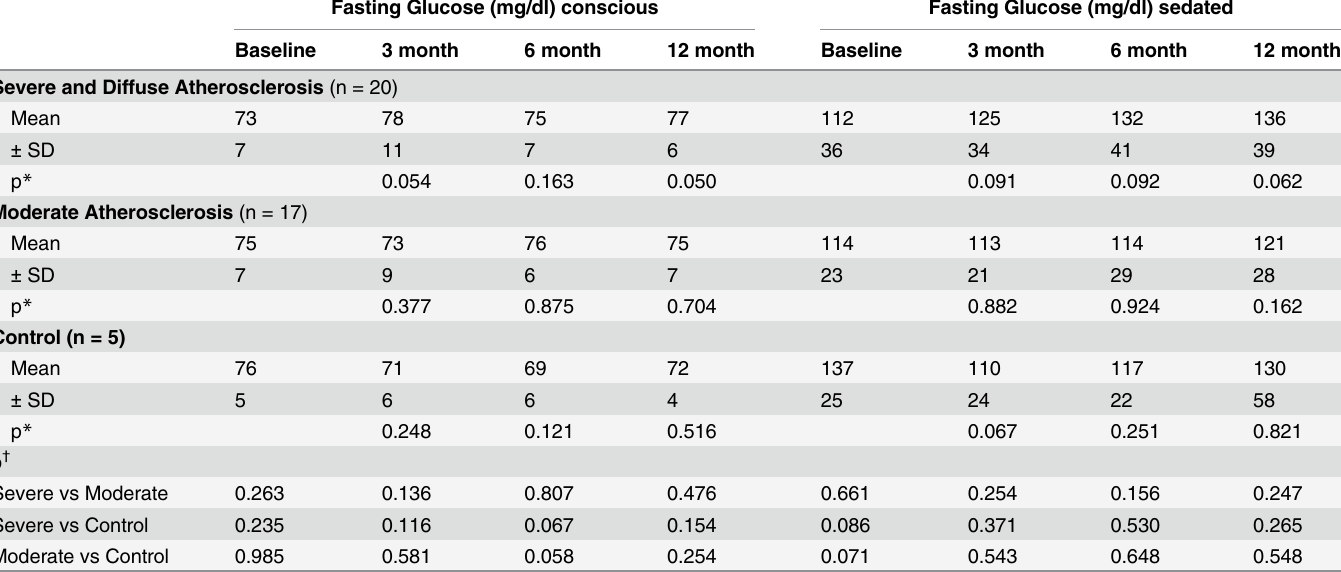
0.235 0.985 0.581 0.058